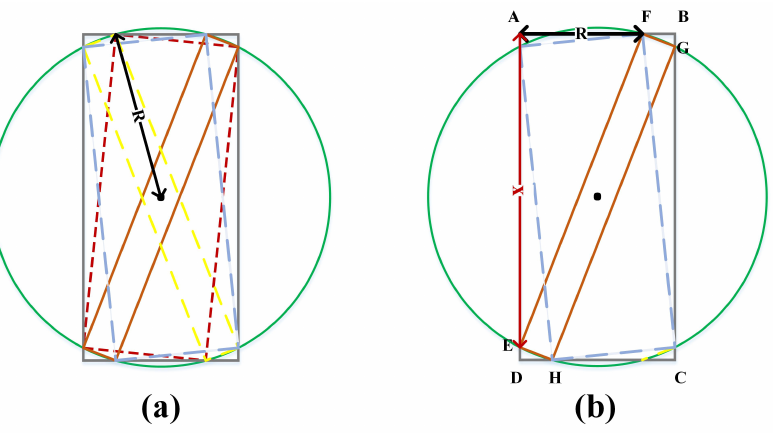
Figure 3. ( a ) The circle marked with the radius of the circle. The circle and the horizontal rectangle will intersect into four inclined rectangles. ( b ) The vertex of the horizontal rectangle and the intersection with the circle, and explains that there are only two inclined rectangles using AF to draw the